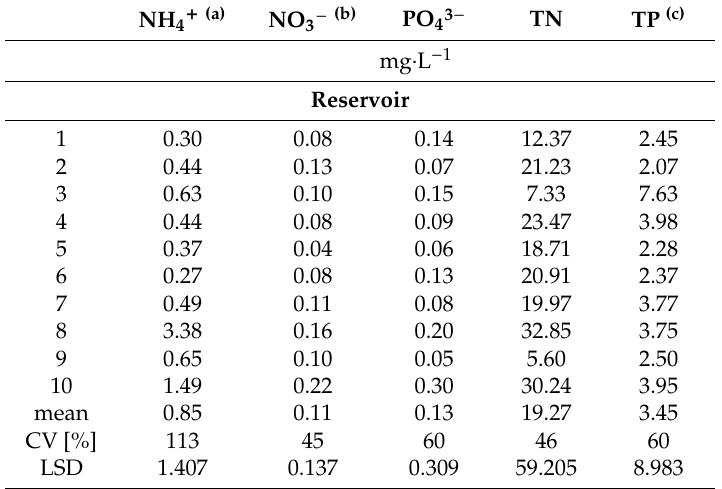
Table 4. Mean values of phosphorus and nitrogen compounds in water in reservoirs 1–10.